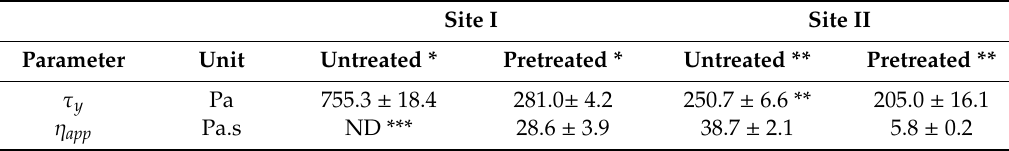
Table 2. Rheological properties for untreated and treated